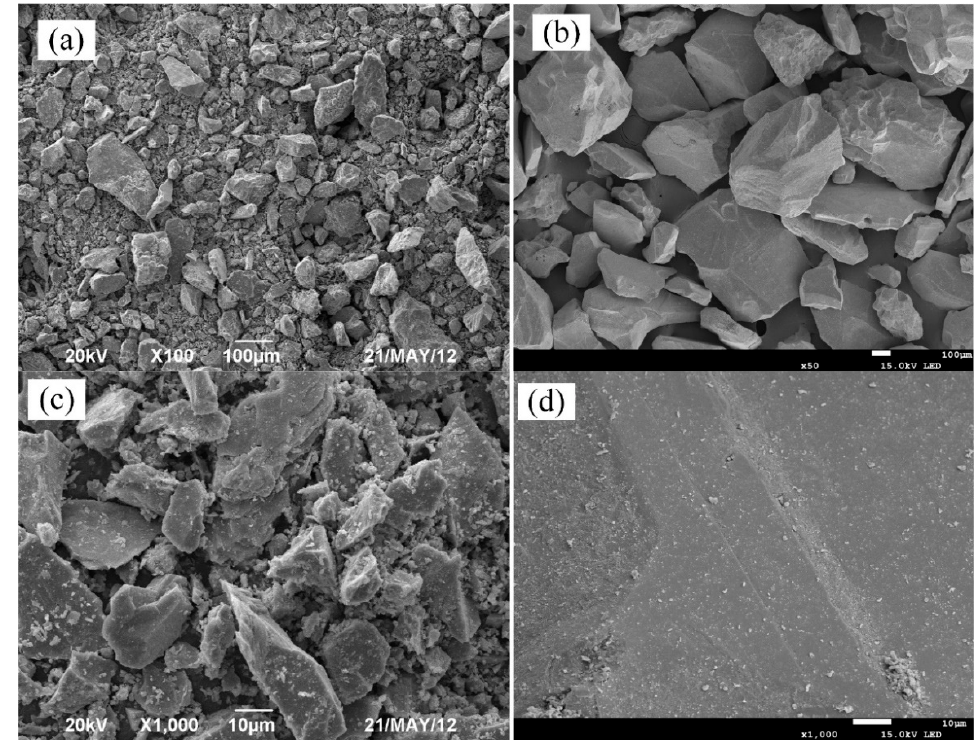
Figure 1. Microstructure of fluorine-bearing iron concentrate ( a , c ) and specularite ( b , d ). The mineralogical phase components of specularite are shown in Figure 2. The XRD pattern of the specularite sample indicates that the main mineral phases of specularite are hematite (Fe 2 O 3 ) and minor SiO 2 .